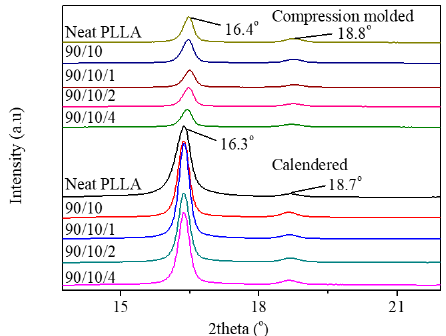
Figure 11. XRD patterns of annealed PLLA and PLLA / EPDM / OMMT (90 / 10 / x) samples prepared by compression-molding and